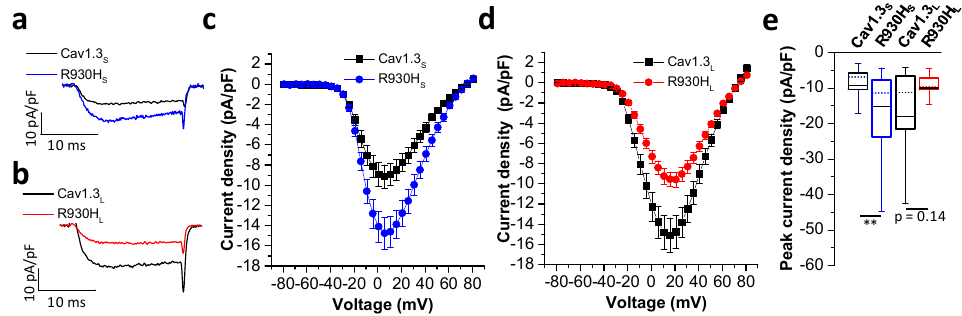
Figure 3. The R930H variant induces transcript variant dependent gating changes of Cav1.3 chan- nels. ( a ) Representative current traces of wild-type Cav1.3 S and mutant Cav1.3 S R930H (R930H S ) or ( b ) wild-type Cav1.3 L and mutant Cav1.3 L R930H (R930H L ) upon a depolarization step to the poten- tial of their maximal inward currents. ( c , d ) Current-voltage relationships of the I Ca (mean ± S.E.M.) of ( c ) wild-type versus mutant short and ( d ) long Cav1.3 transcript variants. Note that the R930H variant enhanced current densities in the short splice variant. In contrast, current densities were reduced in the mutant long splice transcript variant. ( e ) Boxplots of the peak current densities obtained from depolarization to the respective voltage of the peak current (displayed as median (dotted lines), 25/75 percentile (whiskers) and mean (black lines)); median and 25/75 percentiles. In pA/pF: wild-type Cav1.3 S : − 6.8 ± ( − 10.5/ − 5.7), n = 32 and R930H S : − 11.3 ± ( − 23.7/ − 7.7), n =